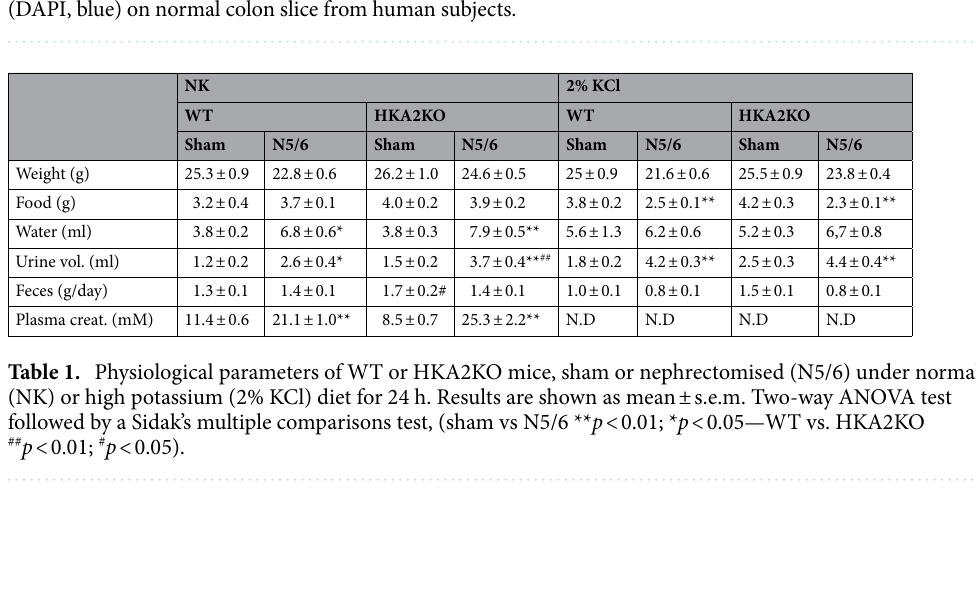
Figure 1. Expression of HKA2 in colon is not influenced by nephronic reduction (N5/6) and K + load. ( A ) mRNA expression of the Atp12A gene encoding for the catalytic subunit of the HKA2 in colon of sham or N5/6 WT mice under normal diet (NK) or after a 24 h load of KCl (2% in drinking water) normalized by the housekeeper gene Rps15 . Results are shown as the mean ± s.e.m (n = 5). ( B ) Western blot detection of the HKA2 α subunit (left panel) in N5/6 mice under NK or after a 24 h load of KCl (2% KCl). The signal is normalized with the Ponceau S Red labeling (right panel). Results are shown as the mean ± s.e.m (n = 5). ( C ) Labelling of the HKA2 α subunit (red) and of nucleus (DAPI, blue) on colon slice from sham and N5/6 mice under NK or after a 24 h load of KCl (2% KCl). For all slides, the pictures were taken with the same parameters of exposition and magnification (×20). Scale bars: 20 µm. D/ Brightfield and labelling of the HKA2 α subunit (red) and of nucleus (DAPI, blue) on normal colon slice from human subjects.